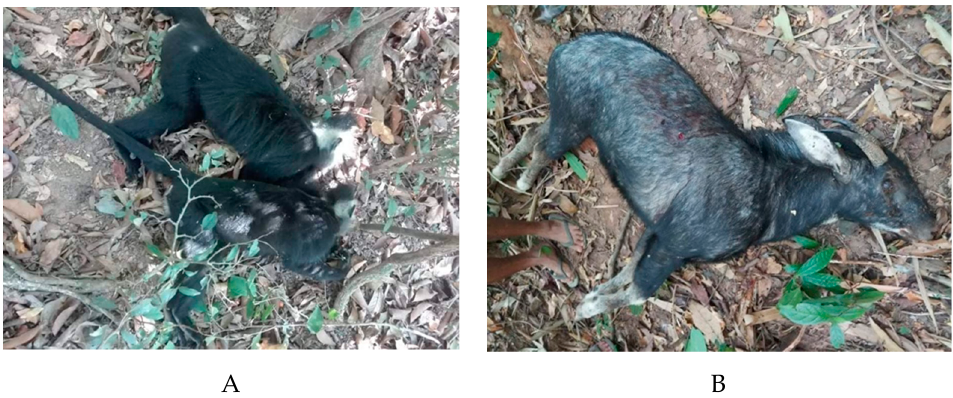
Figure 5. Evidence of poaching within the protected area. Poaching is still one of the main threats to the survival of wildlife. In this figure: A : two Laotian langur killed in Ban Natan; B : serow killed in Hinboun. Photos obtained from anonymous